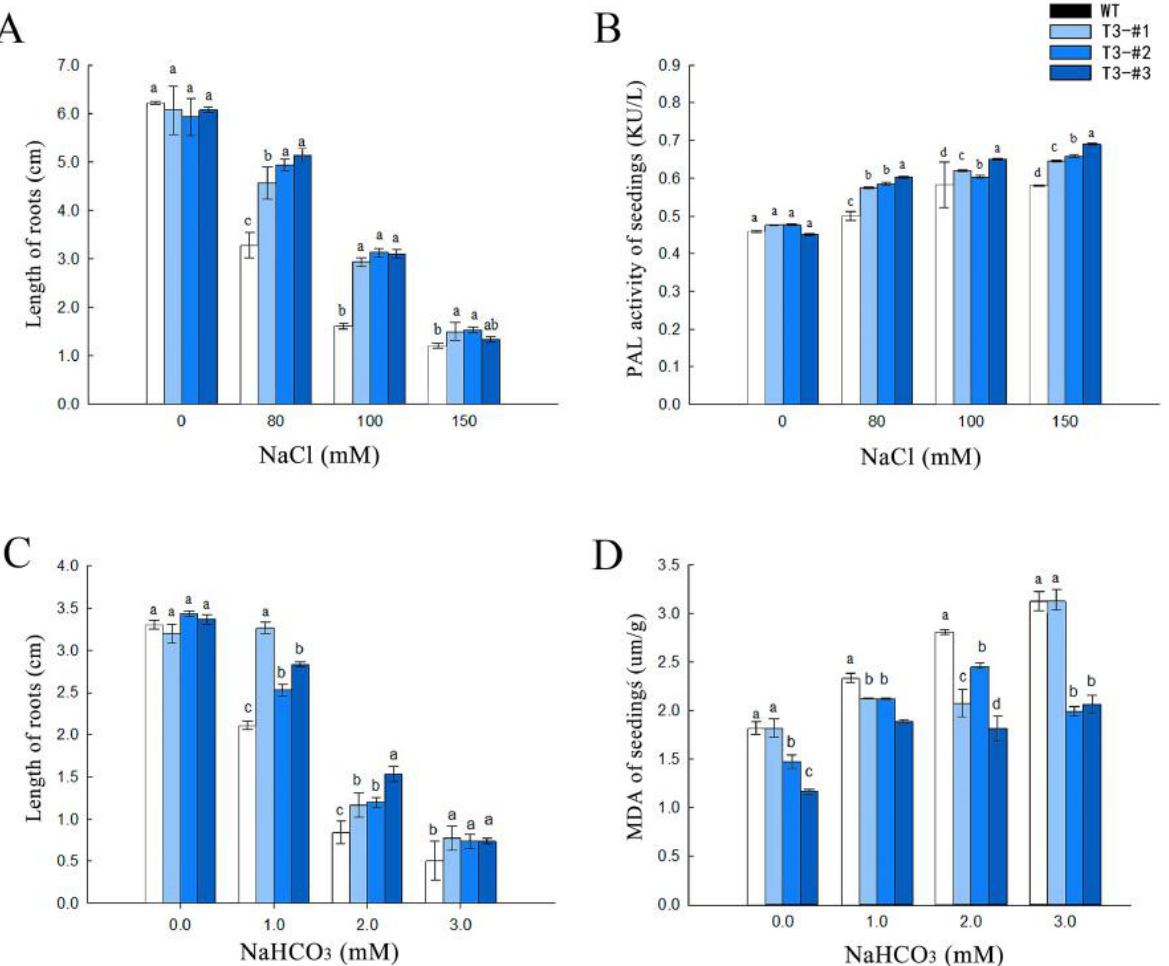
Figure 5. Seedling root growth under either NaCl or NaHCO 3 treatment. ( A ) Root length under NaCl treatment. ( B ) PAL enzyme activity under NaCl. ( C ) Root length under NaHCO 3 treatment. ( D ) MDA levels under NaHCO 3 treatment. Marking: The letters on the bar chart are marked for significance analysis. Where there is one same marking letter, the difference is not significant; where there is different marking letters, the difference is significant. The more different letters are, the more significant they are.